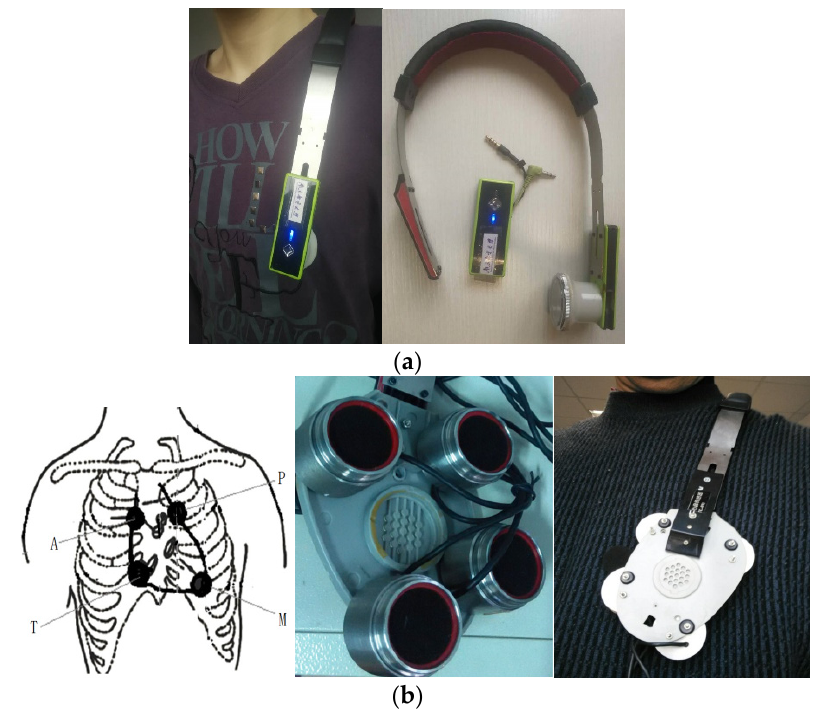
Figure 1. Single-channel and four-channel heart-sound collectors: ( a ) shoulder-strap-type single- channel wireless heart-sound collector; ( b ) schematic diagram of 4 auscultation areas and 4-channel heart-sound collectors.